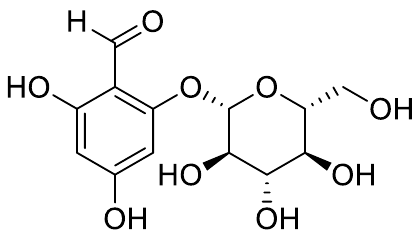
Figure 1. Structure of 2- O - β - D -glucopyranosyl-4,6-dihydroxybenzaldehyde (GDHBA).